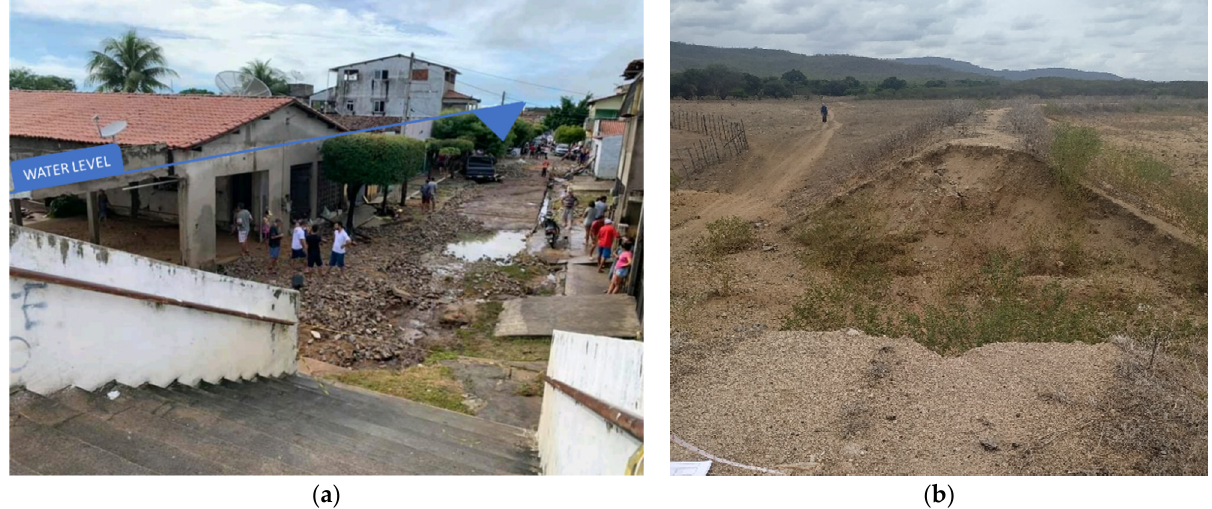
Figure 7. ( a ) Water level reached during the flood event marked at the walls affected by the flood. ( b ) Dam breach in a small reservoir upstream of the city.